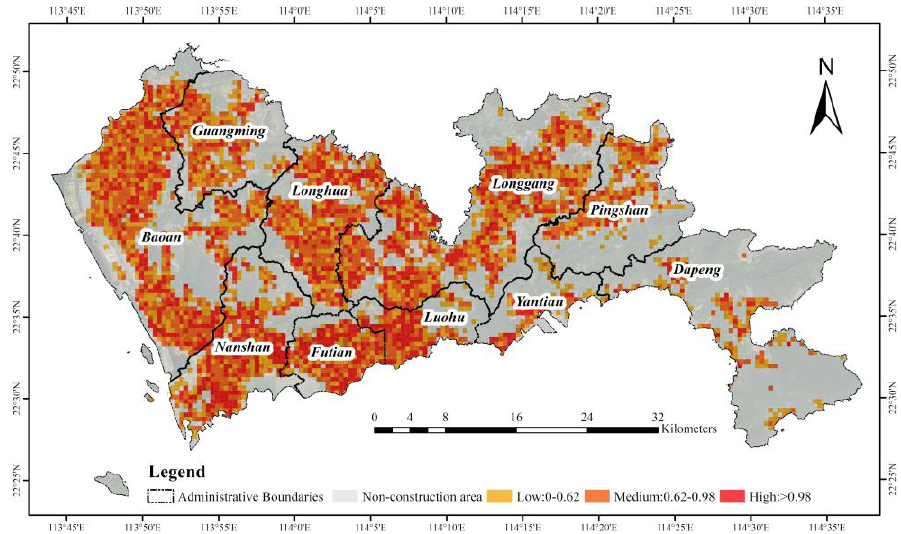
Figure 5. Mixed entropy distribution of functional construction land zones at 500 m grid scale.